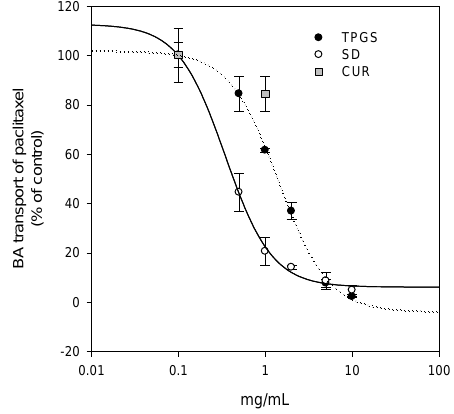
Figure 8. Inhibitory effect of TPGS ( ) and solid dispersion formulation (SD, ○ ) on P-gp transport activity. B to A transport rate of 5 μM paclitaxel was measured in the presence of curcumin (0.1 and 1 mg/mL), TPGS (0.1, 0.5, 1, 2, 5, and 10 mg/mL), or solid dispersion formulation (0.1, 0.5, 1, 2, 5, and 10 mg/mL as TPGS) in LLC-PK1-P-gp cells. Each data point represents the mean ± S.D. of three independent experiments.